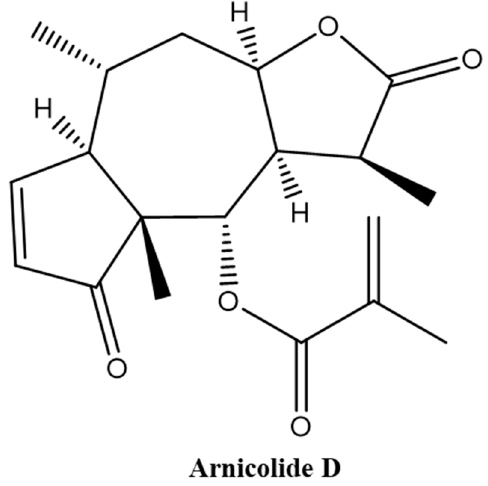
Figure 1. Chemical structure of Arnicolide D.